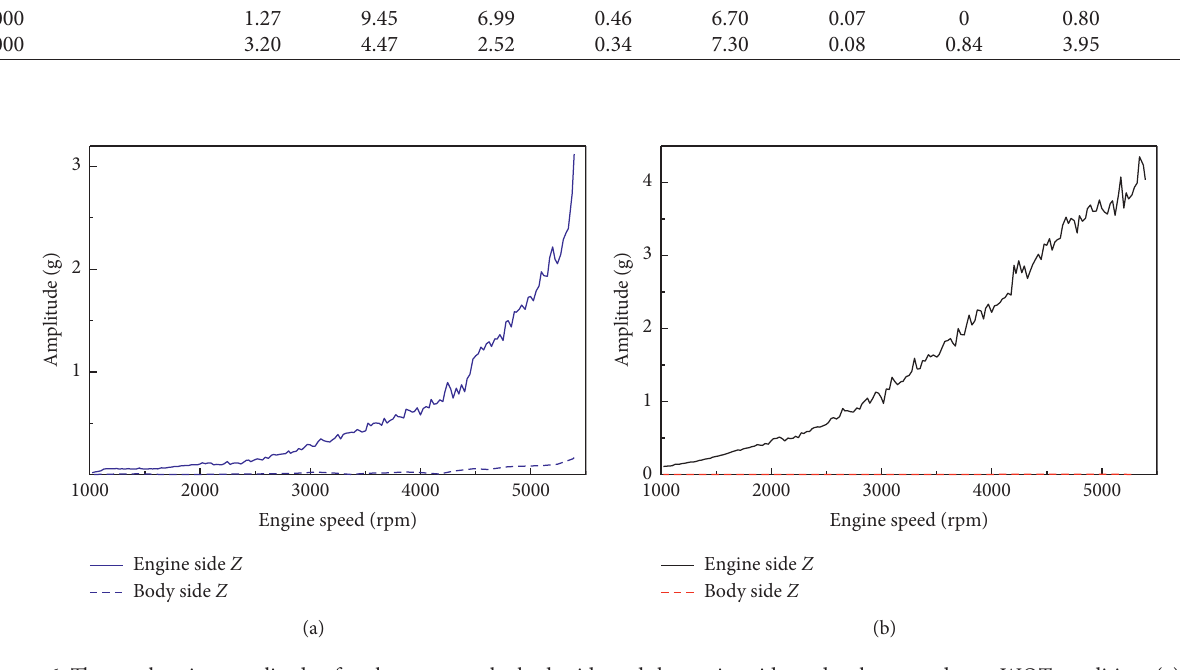
Figure 6: The acceleration amplitude of each mount at the body side and the engine side under the second gear WOT condition. (a) Left mount. (b) Right mount.